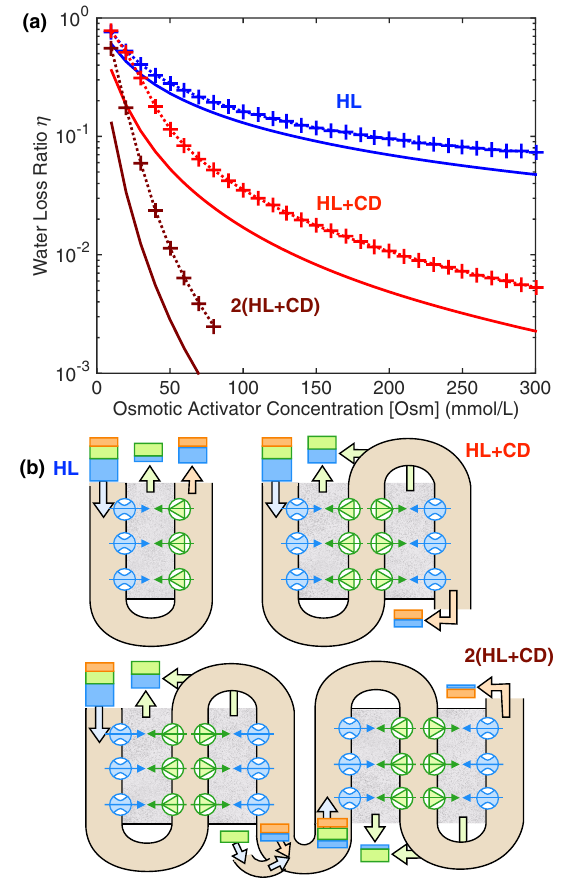
FIG. 3. Separation ability and minimal bounds. (a) Water loss =q in ratio η ¼ q out as a function of the initial concentration of Water Water osmotic activator ½ Osm (cid:2) in (salt). Both the numerical results (crosses and dotted lines) and the predicted lower bounds (solid lines) are reported, for the single loop (HL), double-loop (HL þ CD) and two double-loop cycles (2 HL þ CD). The latter quantities are given by Eqs. (4) and (6) for the HL and HL þ CD geometries, respectively. Numerical data are calculated with parameters L ¼ 4 mm, P f ¼ 2500 μ m = s, n ¼ 3 . (b) Schematics of the nephron-inspired systems studied in